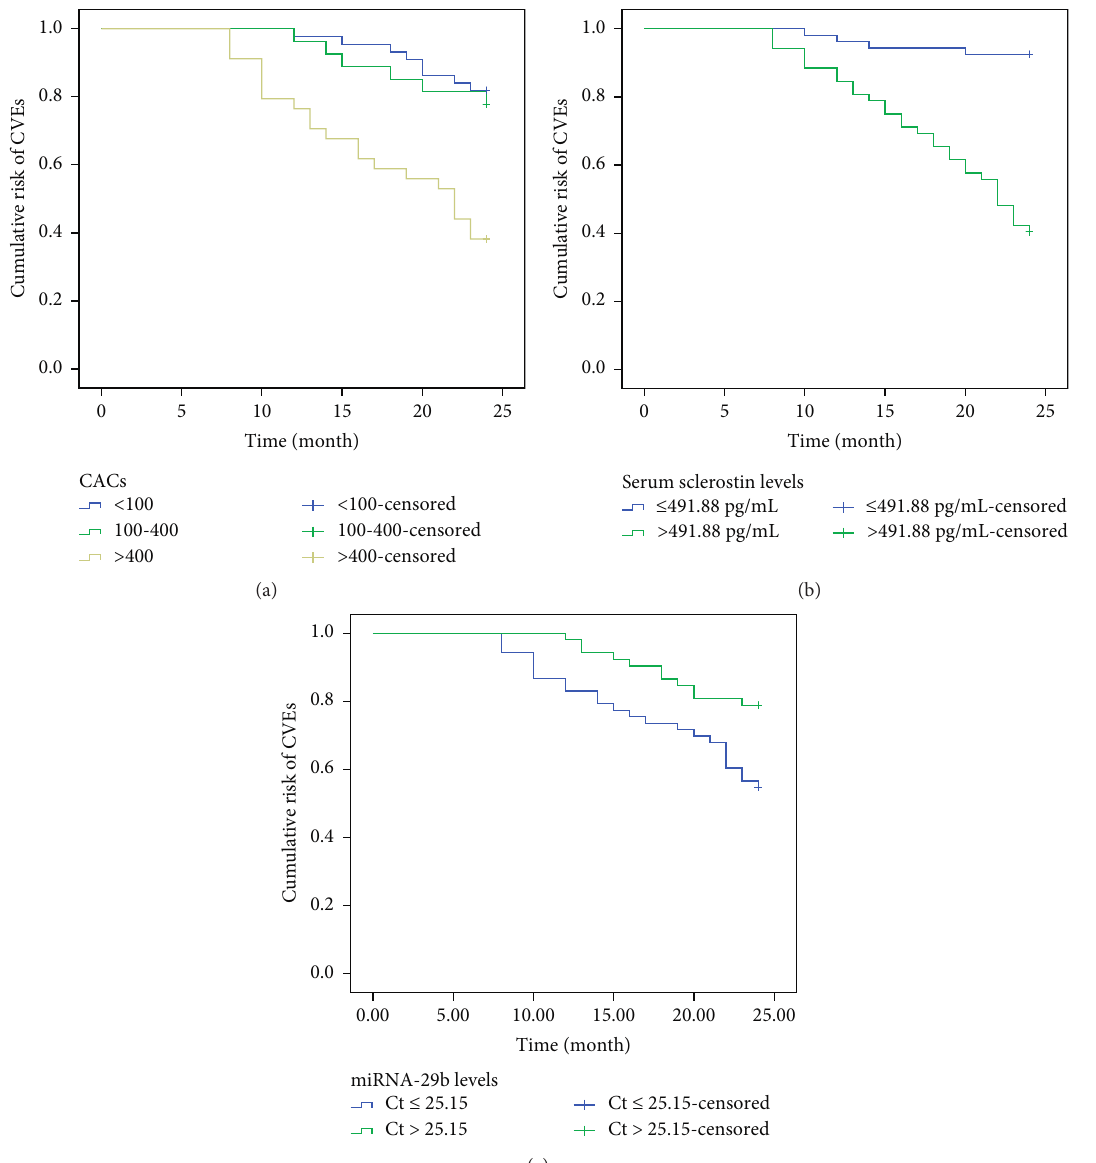
Figure 3: Serum levels of sclerostin and miRNA-29b were correlated with CVEs in MHD patients. (a) The Kaplan–Meier method with the log-rank test to estimate the cumulative risk of CVEs in MHD patients according to CACs. (b) The Kaplan–Meier method with the log-rank test to estimate the cumulative risk of CVEs in MHD patients according to serum levels of sclerostin (491.88 pg/mL as cutoff). (c) The Kaplan–Meier method with the log-rank test to estimate the cumulative risk of CVEs in MHD patients according to serum levels of miRNA- 29b (Ct of 25.15 as